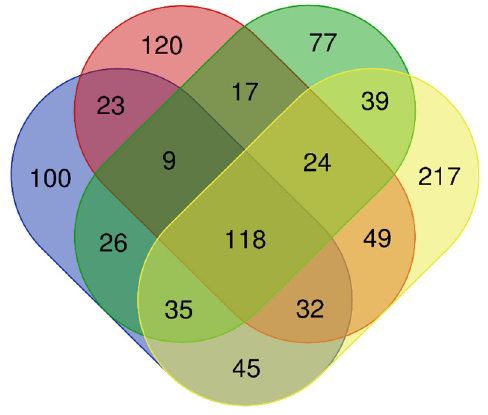
Figure 7. Venn diagram indicating the diversity of the fungal OTUs found in the 1st–4th year Pinus sylvestris L. plantations and the number of fungal OTUs shared across all plantations; the data obtained at three study sites (A, L, and V) were combined. Different colours represent different study sites: blue—1st year plantations, red—2nd year plantations, green—3rd year plantations, and orange—4th year plantations.